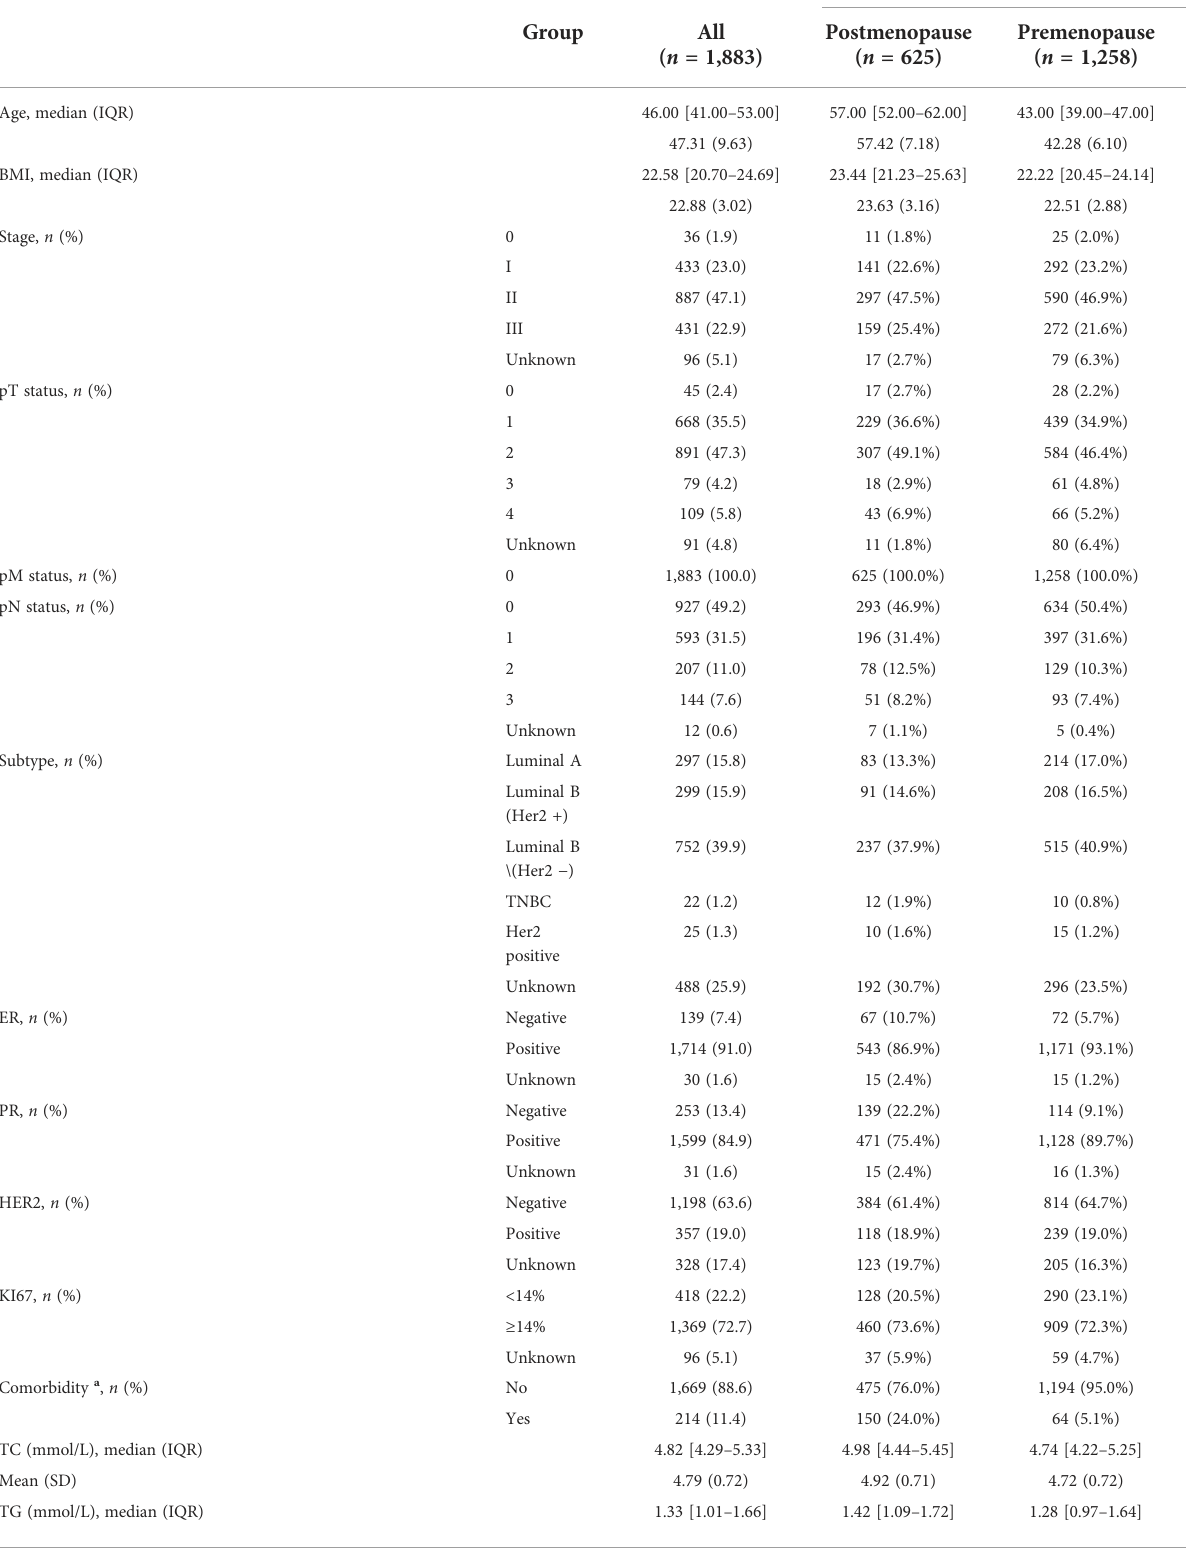
TABLE 1 Characteristics and dyslipidemia risk among early-stage breast cancer